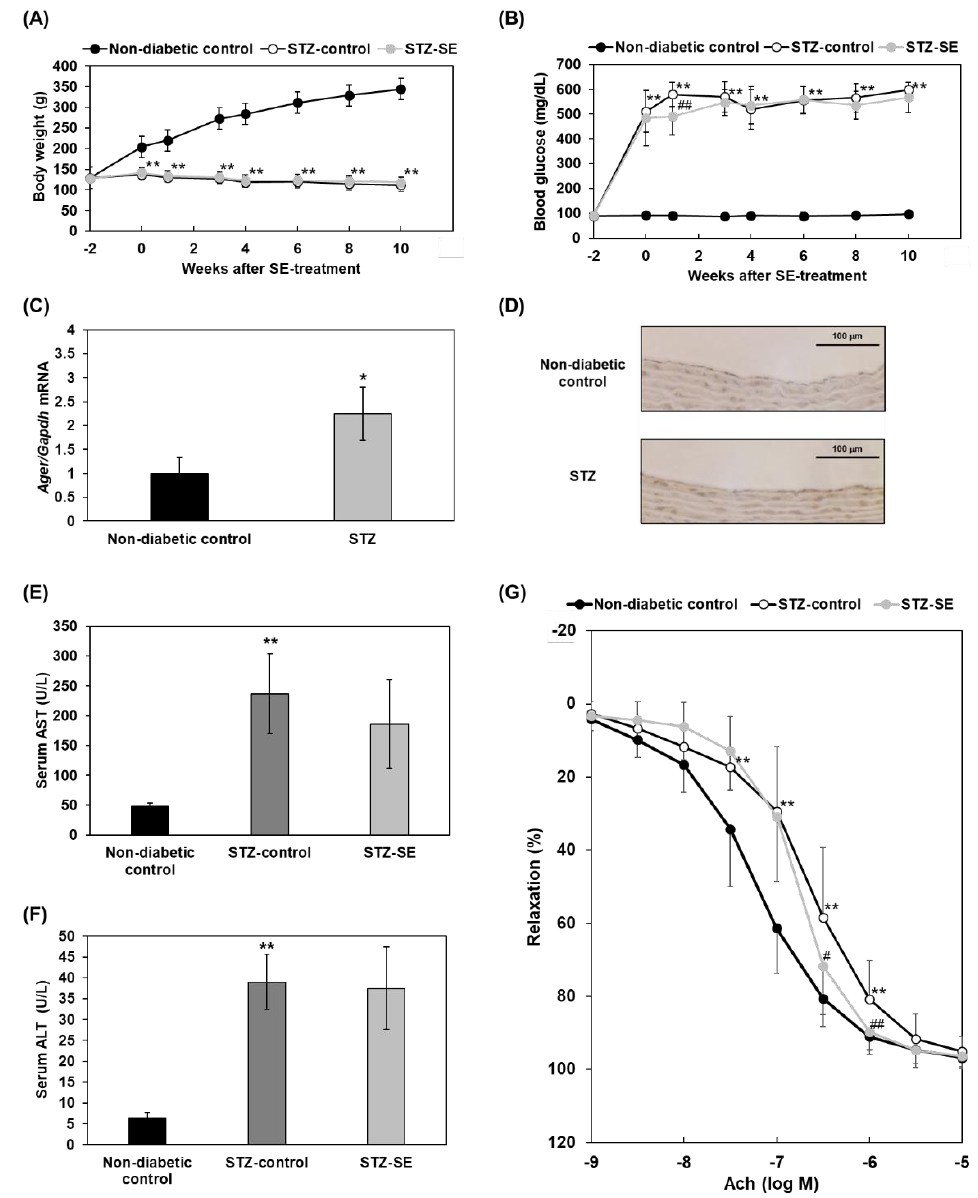
Figure 3. Beneficial effects of SE on vascular relaxation in STZ-induced diabetic rats. Rats were intraperitoneally injected with STZ (50 mg/kg), and the STZ-SE group was treated with 0.1% SE-mixed chow for 10 weeks. ( A ) Body weights. Data are expressed as mean ± SD (n = 6–9). **, p < 0.01 vs. Non-diabetic control. ( B ) Blood glucose levels. Data are expressed as mean ± SD (n = 6–9). **, p < 0.01 vs. Non-diabetic control. ## , p < 0.01 vs. STZ-control. ( C ) Ager mRNA expression in aortas at 10 weeks after STZ administration by qPCR. Data are expressed as mean ± SD (n = 3). *, p < 0.05 vs. Non-diabetic control. ( D ) RAGE protein expression in endothelia of the thoracic aortas were observed by immunohistochemistry. ( E ) Serum AST levels. Data are expressed mean ± SD (n = 6–9). **, p < 0.01, vs. Non-diabetic control. ( F ) Serum ALT levels. Data are expressed mean ± SD (n = 6–9). **, p < 0.01, vs. Non-diabetic control. ( G ) Vascular relaxation. Cumulative concentrations of acetylcholine (10 −9 to 10 −5 M) were added to the chamber, and the tension was recorded. Data are expressed as mean ± SD (n = 6–9). **, p < 0.01 vs. Non-diabetic control. # , p < 0.05, vs. STZ-control; ## , p < 0.01 vs. STZ-control. STZ-SE, SE-treated and STZ-induced rats; Ach, acetylcholine; Gapdh, Glyceraldehyde-3-phosphate dehydrogenase; AST, aspartate aminotransferase; ALT, alanine aminotransferase.